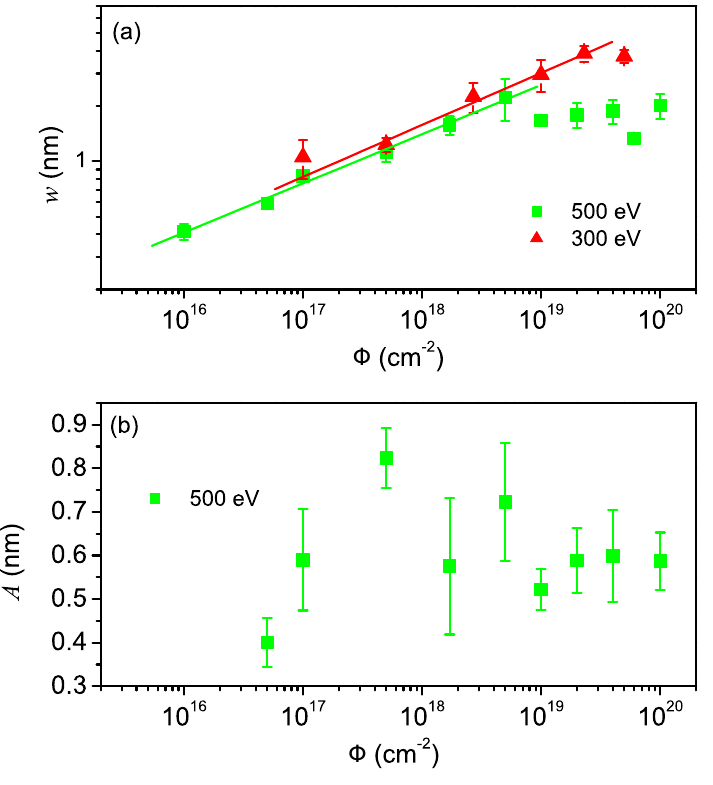
Surface roughness w (a) and ripple amplitude A (b) versus fluence. The solid lines in (a) represent power law fits, yielding growth exponents of β = 0 . 28 ± 0.03 and β = 0 . 27 ± 0.02 for 500 eV and 300 eV, respectively